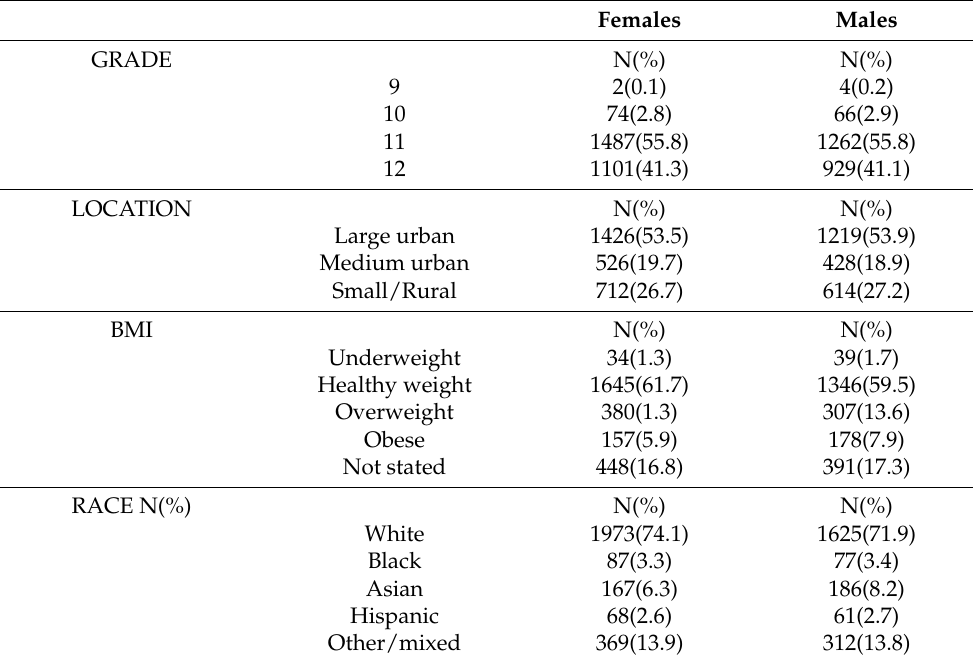
Table 2. Demographic and descriptive statistics of participants at Time 1 (2016/17) for smoking initiation in the COMPASS study at Time 2